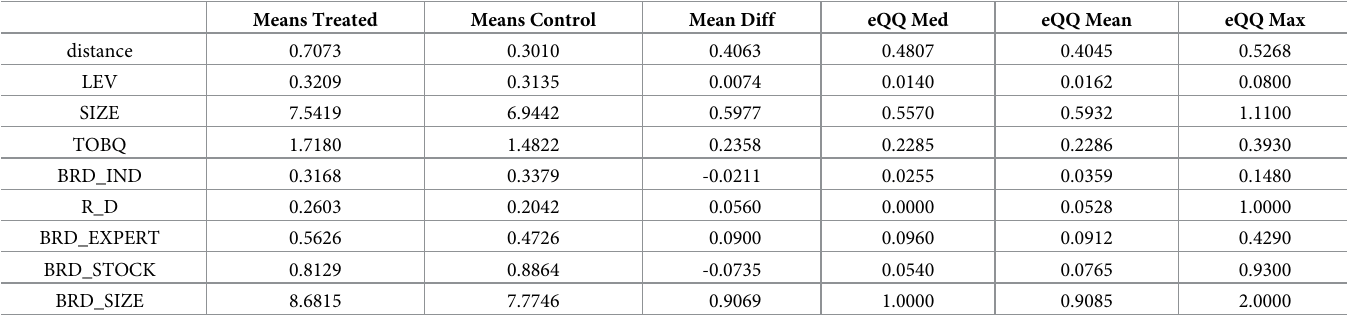
Table 6. Summary of balance for all